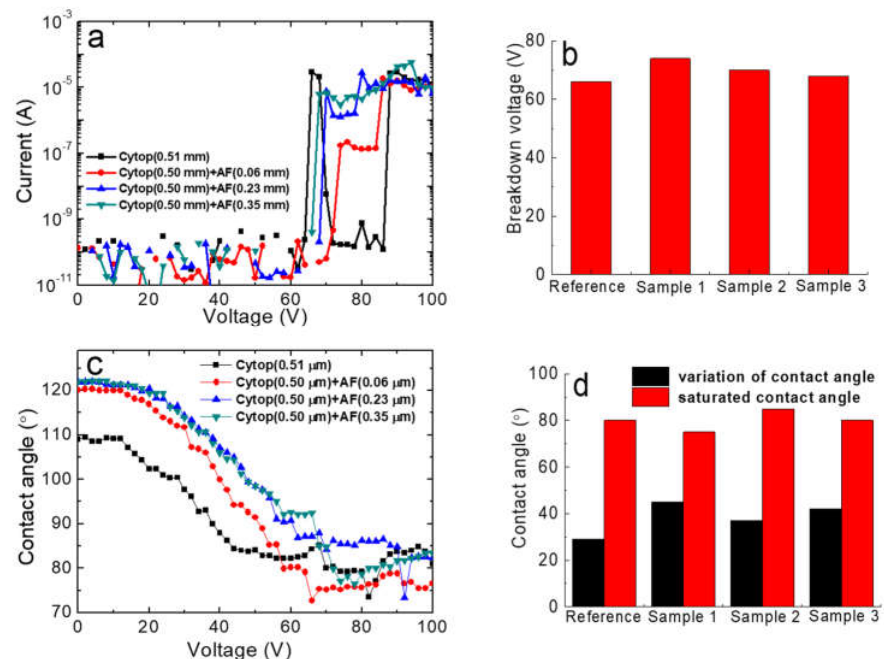
Figure 8. ( a ) Leakage current measurement, ( b ) breakdown voltage, ( c ) electrowetting measurement, and ( d ) contact angle variation and saturated contact angles of the single-layer Cytop coating reference samples. Sample 1: 0.5 µ m Cytop bottom coating and 0.06 µ m Teflon AF top coating; Sample 2: 0.5 µ m Cytop bottom coating and 0.23 µ m Teflon AF top coating; Sample 3: 0.5 µ m Cytop bottom coating and 0.35 µ m Teflon AF top coating.